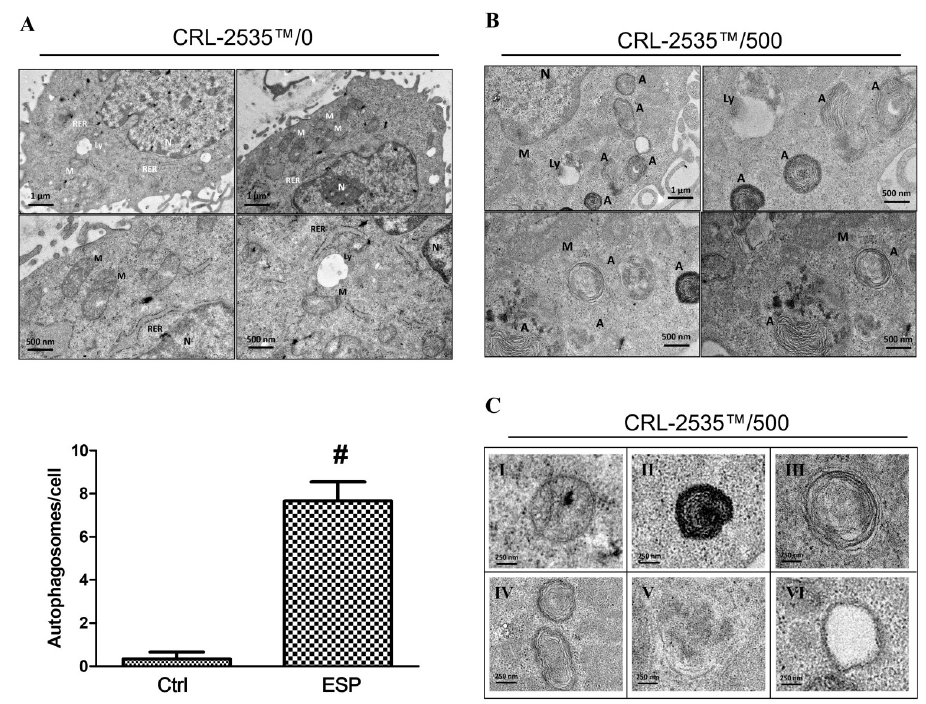
Fig 3. Excretory/secretory products of A . cantonensis L5 stimulate autophagic-like vacuole formation. Cells were (A) left untreated or (B) treated with 500 μ g/ml A . cantonensis L5 excretory/secretory products (ESPs) for 12 h. The formation of autophagic-like vacuoles was detected by using transmission electron microscopy (TEM) (A: autophagosomes. M: mitochondria. Ly: lysosomes. RER: rough endoplasmic reticulum. N: nucleus). (C) TEM images of autophagic structures upon ESPs treatment ((I) (II) autolysosomes with dark undigested content; (III) autophagosomes; (IV) autolysosomes filled with undigested lipids; (V) phagophores; and (VI) empty autophagic-like